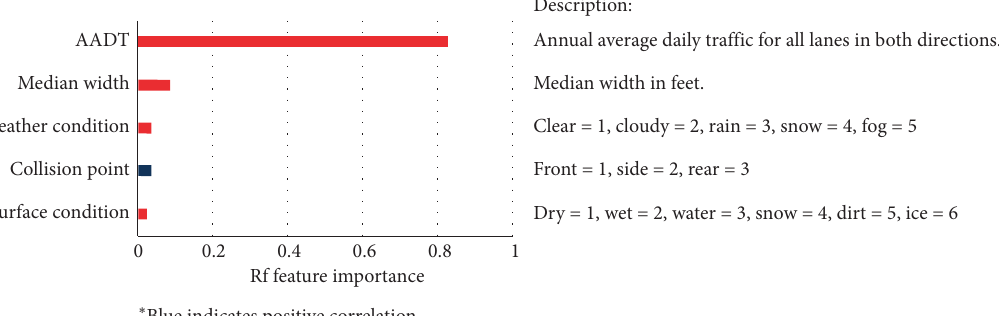
Figure 2: Severity feature